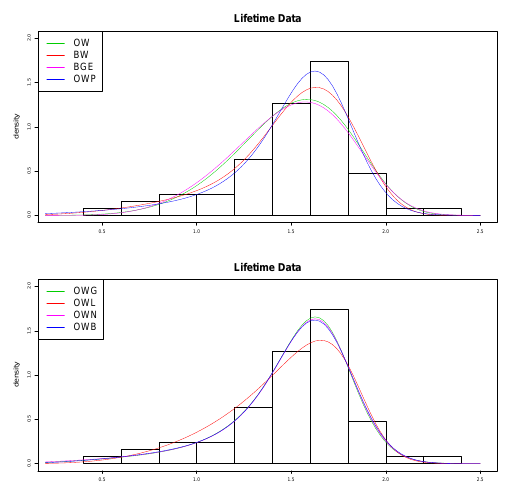
Figure 3 – Estimated pdfs of the OWPS and other competitive distributions for the first data set.